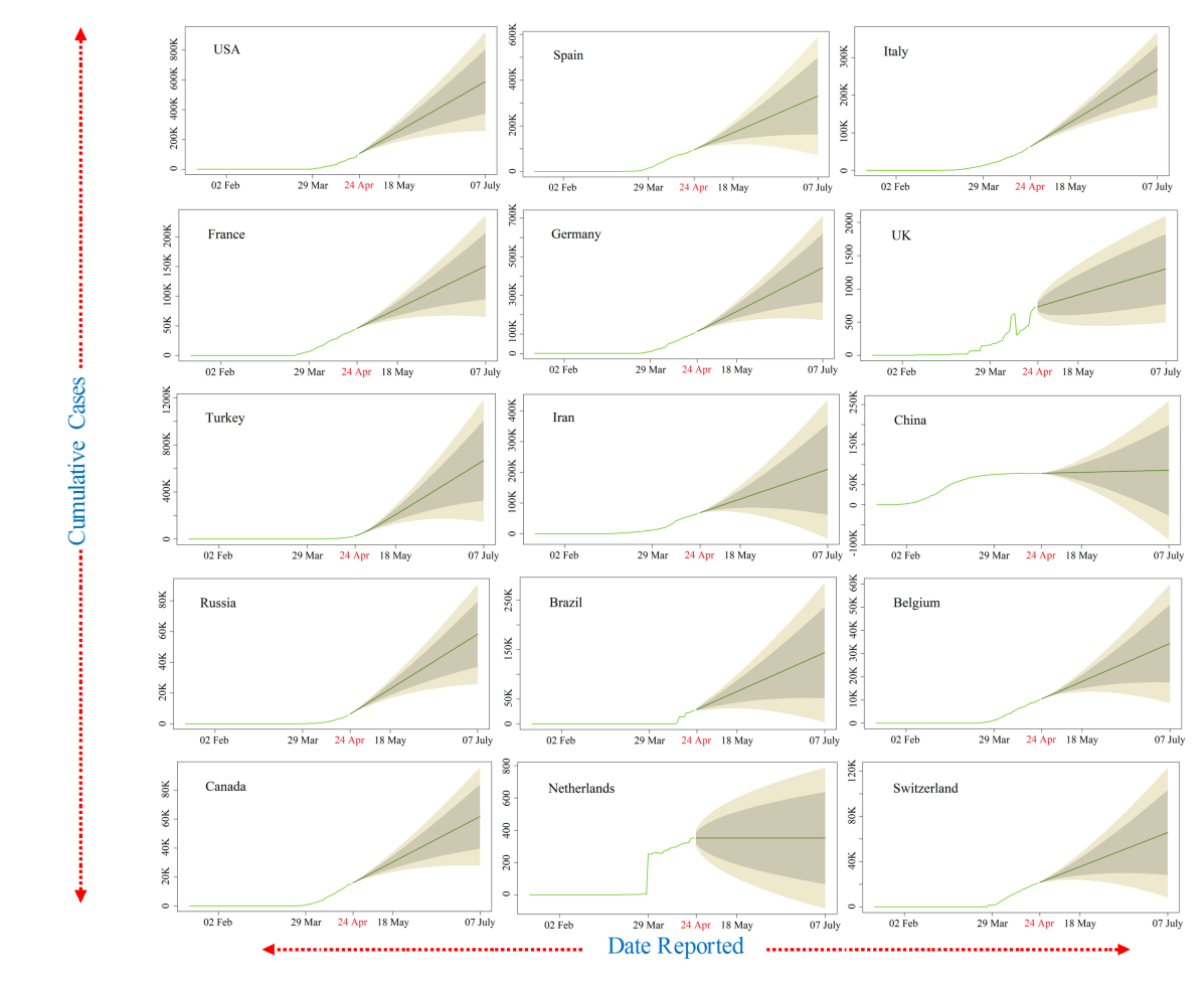
Figure 5. The autoregressive integrated moving average model prediction for more than 2 months of cumulative confirmed coronavirus disease cases in the top 15 affected countries shown in a green color (95%